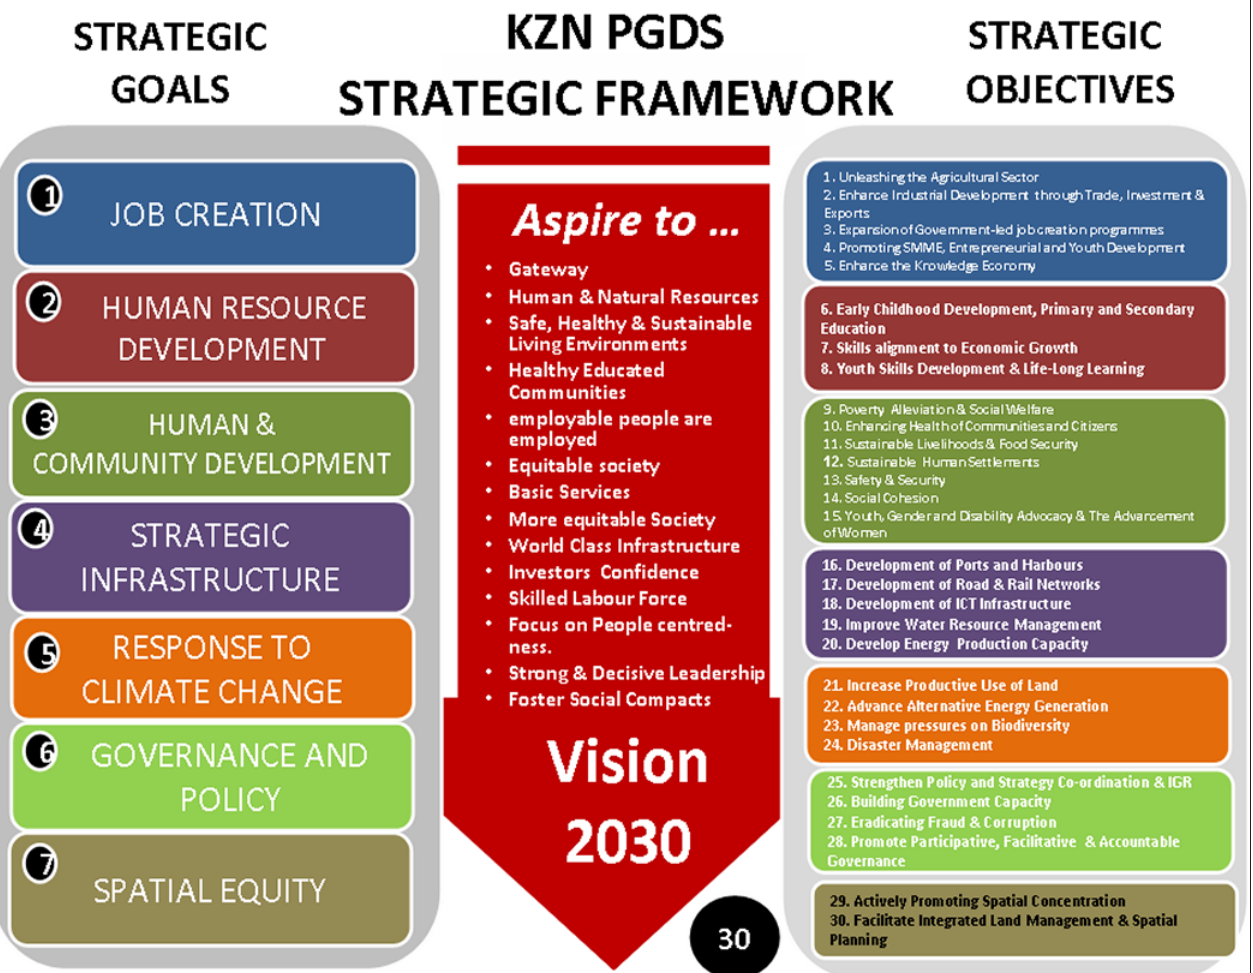
Figure 4: PGDS strategic framework